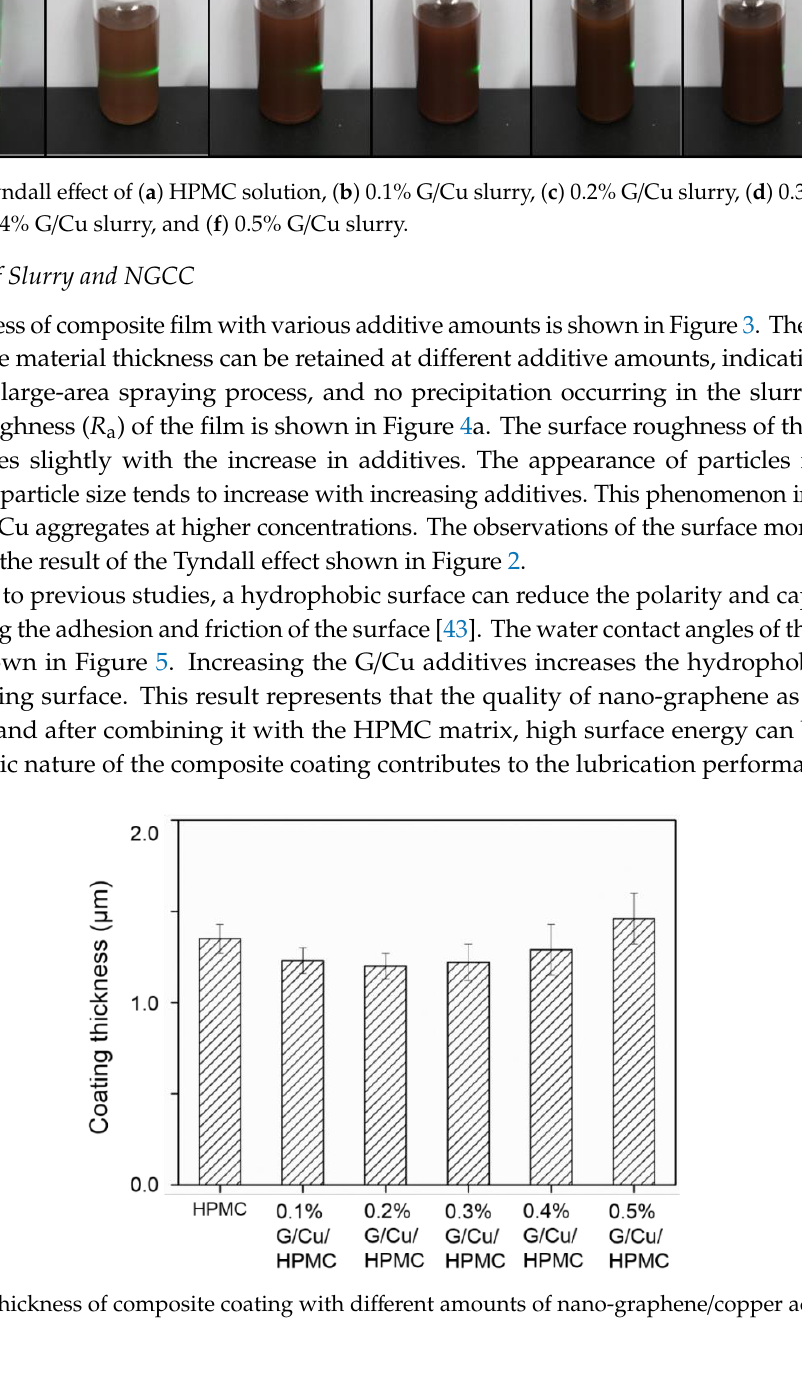
Figure 3. Thickness of composite coating with different amounts of nano-graphene/copper additive.